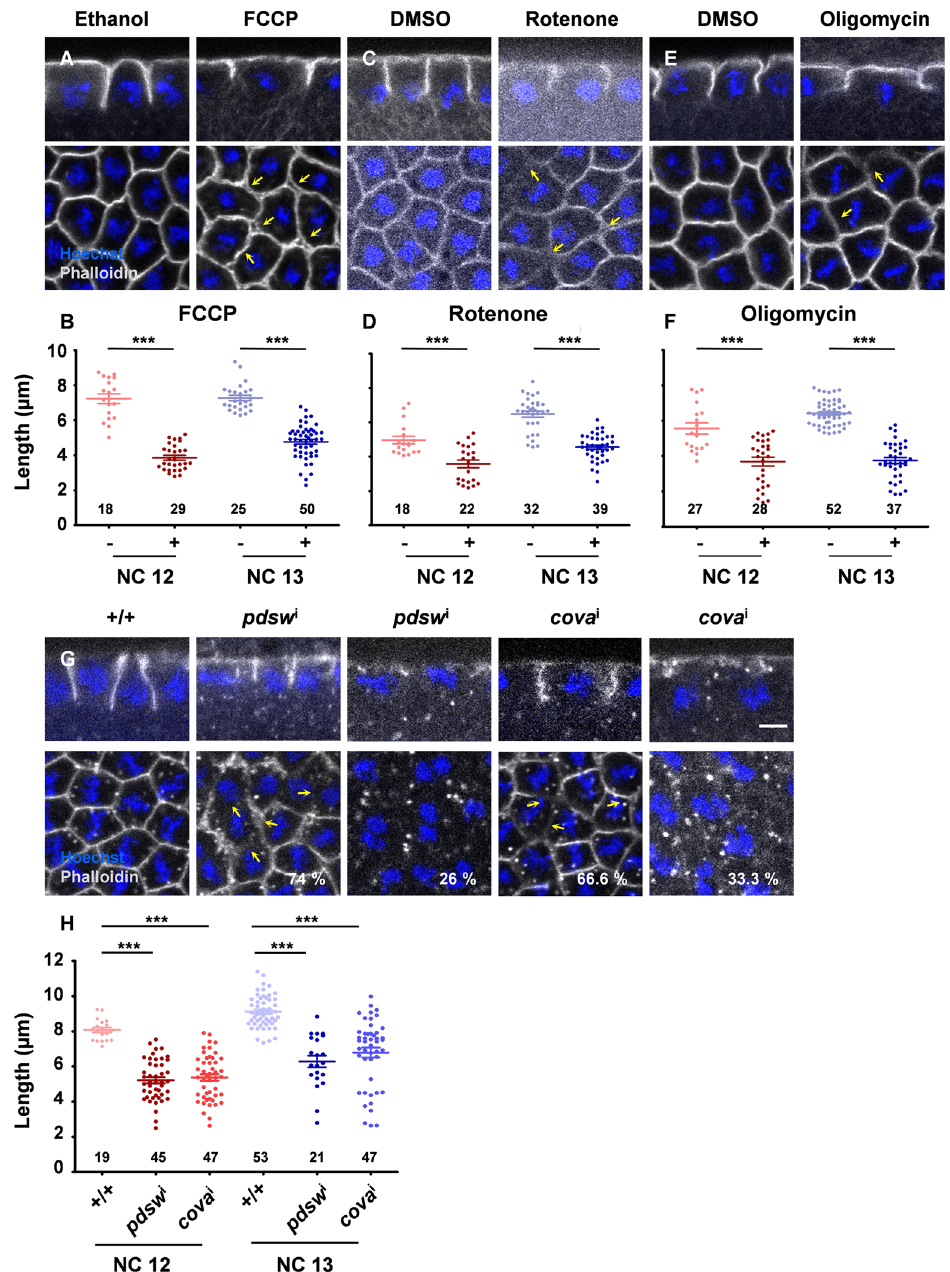
Figure 6. Inhibition of ETC decreases metaphase furrow extension in syncytial Drosophila embryos. ( A – F ) Pharmacological inhibition of ETC results in decrease in metaphase furrow length in NC12 and 13. Shorter metaphase furrows (Phalloidin; grey) are seen in FCCP compared to control in representative sagittal views through metaphase furrows and Surface view shows loose actin organisation ( A ). Furrow length similarly decreased in Rotenone ( C ) and Oligomycin ( E ) compared to respective controls. Quantification of metaphase furrow length shows a significant decrease ( B , D , F ) in NC12 and 13. Each data point represents individual metaphase furrow lengths, NC12 Control n = 18 (4 embryos), FCCP: 29 furrows (6); NC13 control n = 25 (6) and FCCP: 50 (11), ( B ); NC12 control n = 18 (5), Rotenone n = 22 (4); NC13 control n = 32 (5), Rotenone n = 39 (6) and ( D ); NC12 control n = 18 (4) and Oligomycin n = 28 (7) and NC13 control 52 (10) and Oligomycin 37 (7) ( F ) ( *** P ≤ 0.001, two tailed Mann Whitney test). Yellow arrows ( A , C , E ) mark loose membrane/actin on drug treatment. N: FCCP, Rotenone and Oligomycin-3. ( G – H ) Genetic inhibition of ETC results in decrease in metaphase furrow length in NC12 and 13. Metaphase furrows are shortened (74%) or completely absent (26%) in pdsw i compared to control ( G ). cova i metaphase furrows are short (66.6%) or absent (33.3%). Yellow arrows mark loosening or loss of the membrane/actin ( G ). Quantification of metaphase furrow lengths in pdsw i and cova i mutant as compared to control embryos ( H ) in NC12 and 13. NC12 control 19 (4 embryos) pdsw i n = 45 metaphase furrows (8) and cova i 47 (8), and; NC13 control 53 (8), pdsw i 21 (4) and cova i 47 (7) and ( H ) ( *** P ≤ 0.001, two tailed Mann Whitney test). N: pdsw i -4, cova i -3. Scale bar: 5 µ